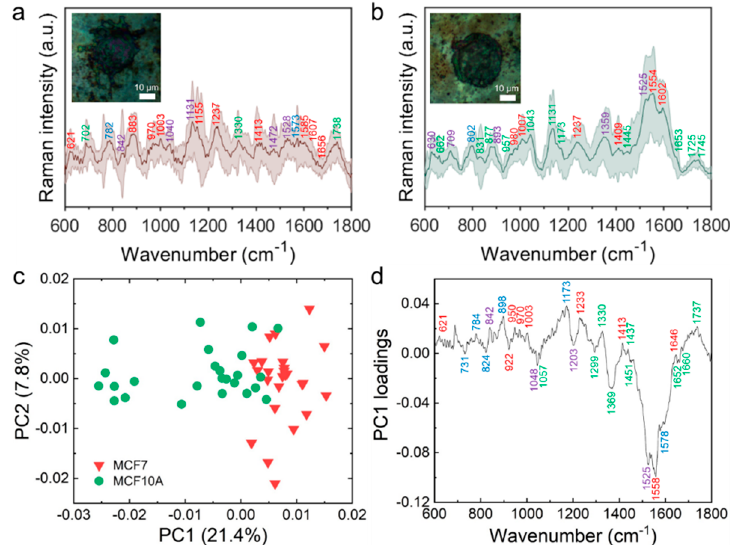
Figure 5. SERS measurement and PCA analysis of the captured living malignant MCF7 cells and non-malignant MCF10A cells. The SERS spectra of MCF7 ( a ) and MCF10A cells ( b ) The measured spectra were followed by Savitzky–Golay smoothing (width = 21, order = 5), background subtraction and normalization. The inset is OM images of the MCF7 and MCF10A cells, respectively. ( c ) Scatter plot of the score values of each Raman spectrum for PC1 and PC2 from the MCF7 (red triangles) and MCF10A (green circles); ( d ) Loading plot of PC1.